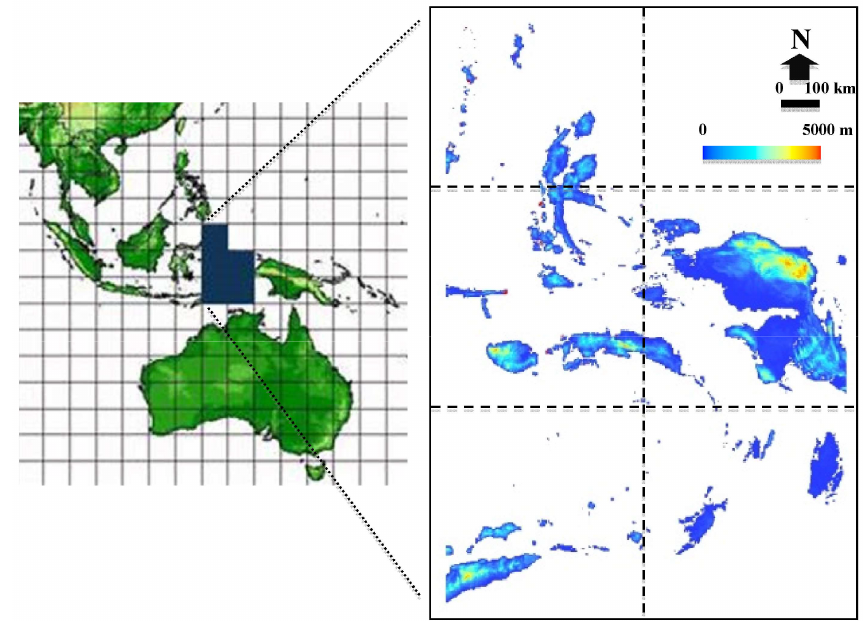
Figure 3. The result of merged and processed DEM tiles on the Maluku